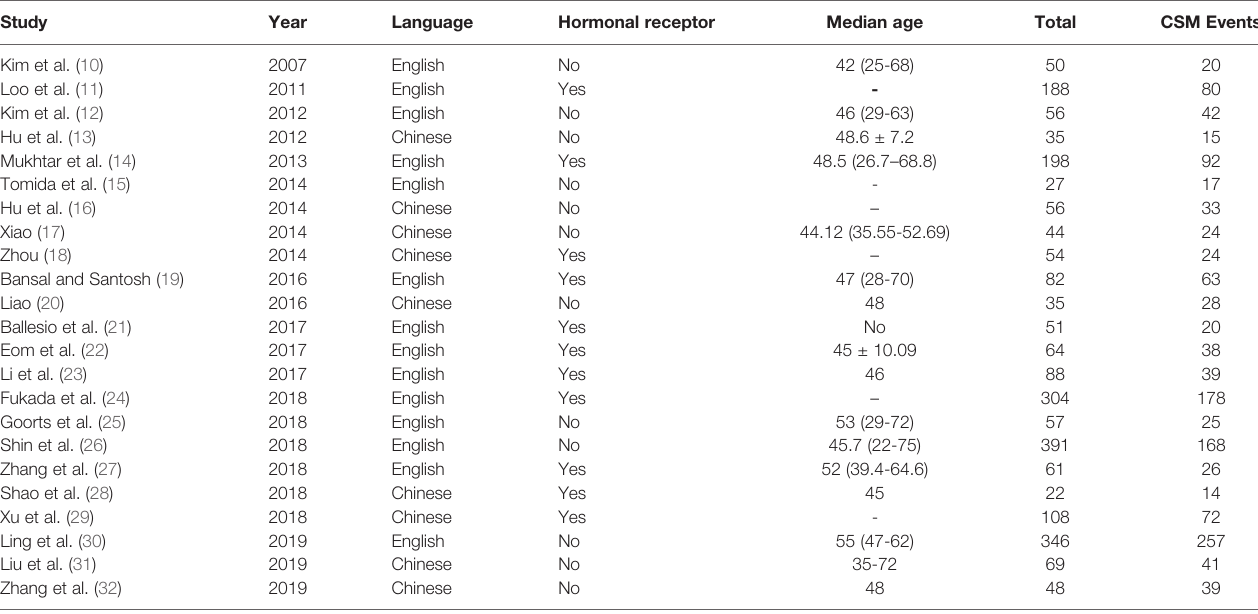
TABLE 2 | Basic characteristics and quality evaluation results of the included studies. Study